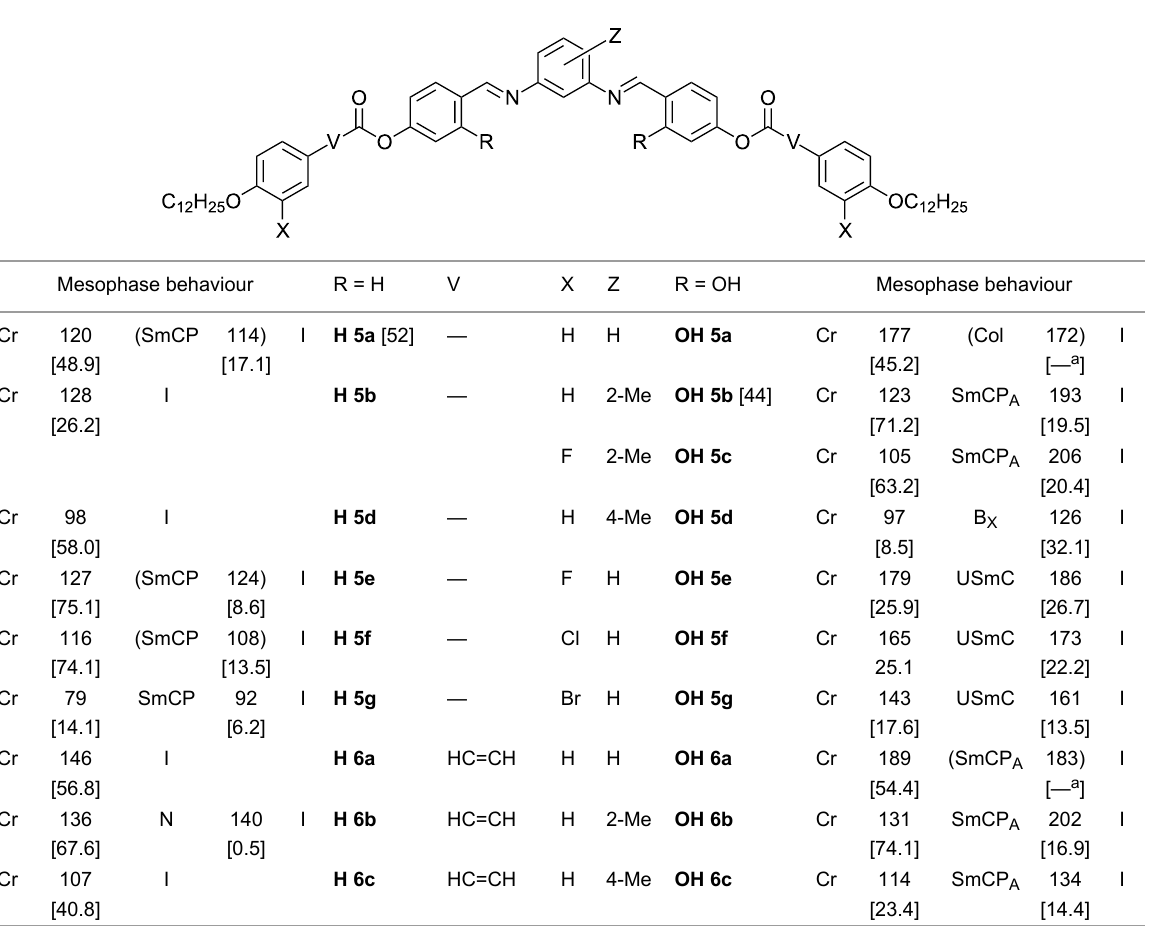
Mesophase behaviour